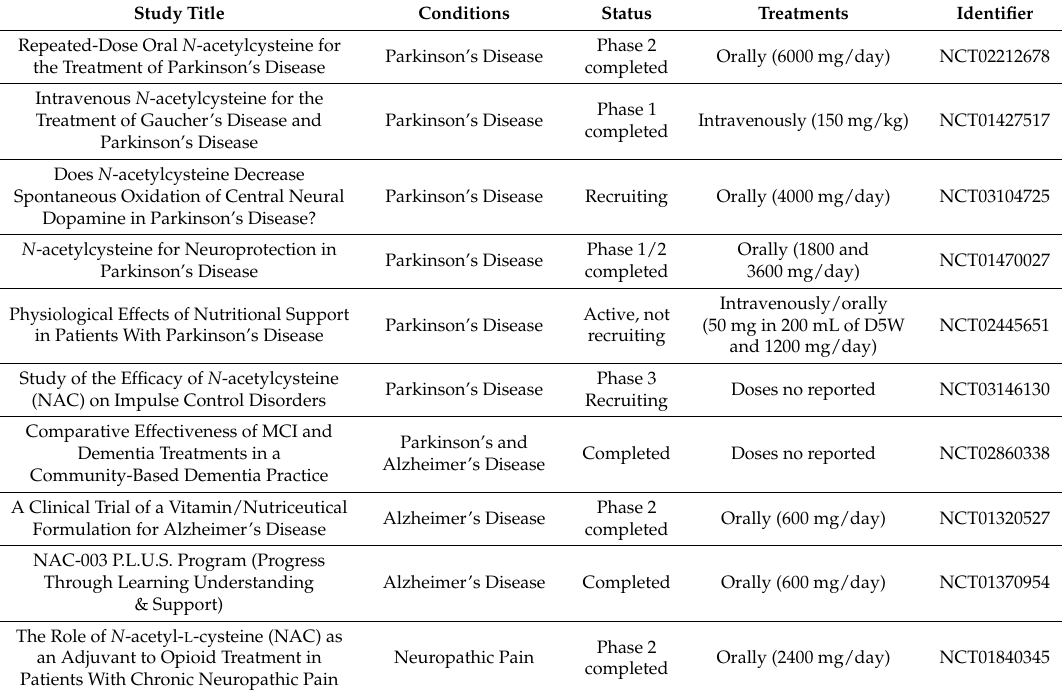
Table 1. N -acetylcysteine: Clinical trials in neurodegenerative diseases (https://clinicaltrials.gov/). Conditions